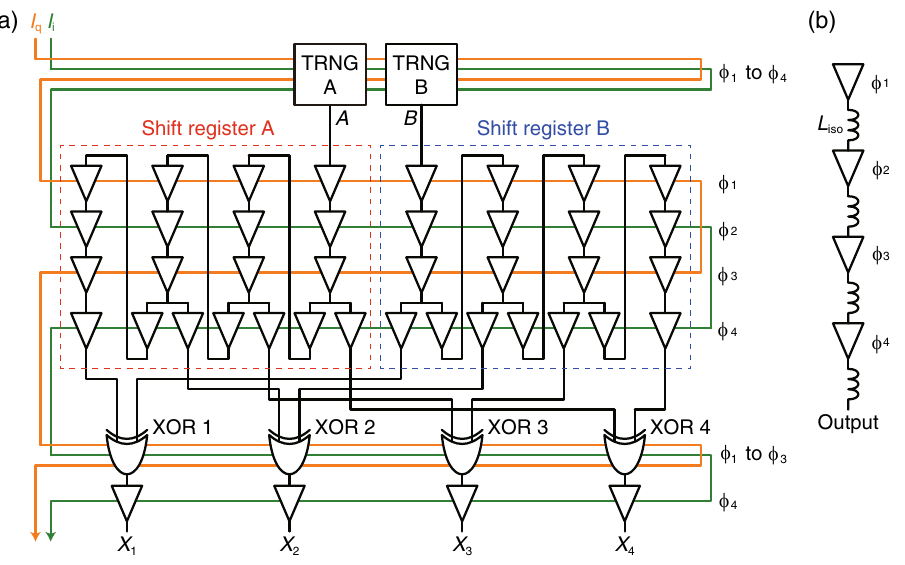
Figure 3. ( a ) AQFP-based XSR circuit for n = 4. The entire circuit is powered and clocked by the paired excitation currents, I q and I i . ( b ) AQFP TRNG. The first buffer generates random bits because no input signal is applied, and the following buffers transmit the random bits to other